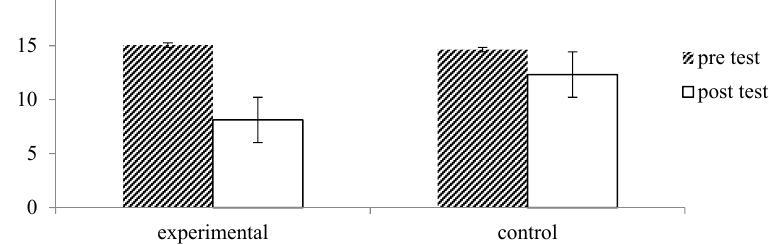
Figure 7. Effect of forest therapy on depression, measured by BDI, with scores ranging from 0–13 = minimal depression, 14–19 = mild depression, 20–28 = moderate depression to 29–62 = severe depression.